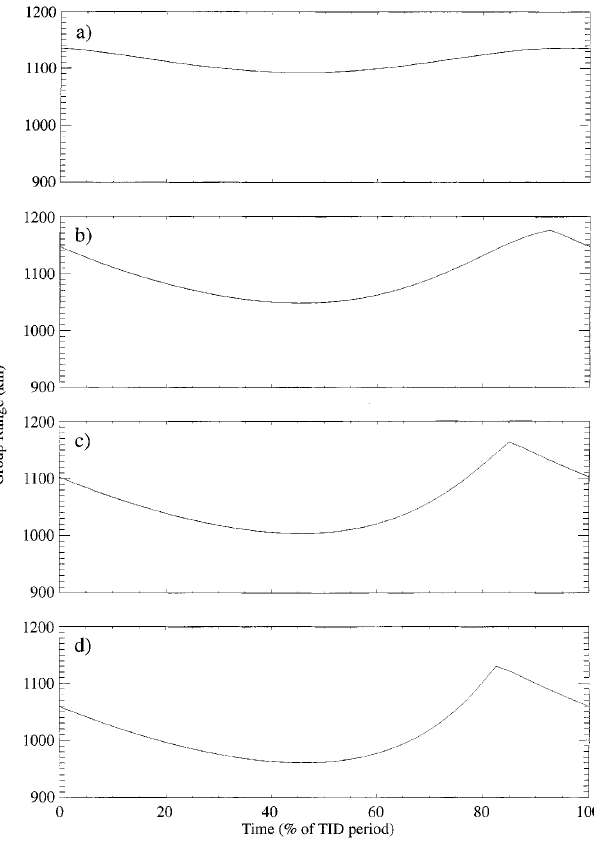
Fig. 6a–d. The skip variation for a radar frequency of 9.97 MHz derived from ray tracing. The perturbation amplitude is a 5%, b 15%, c 25% and d 35%. With no perturbation the skip is at 1115 km